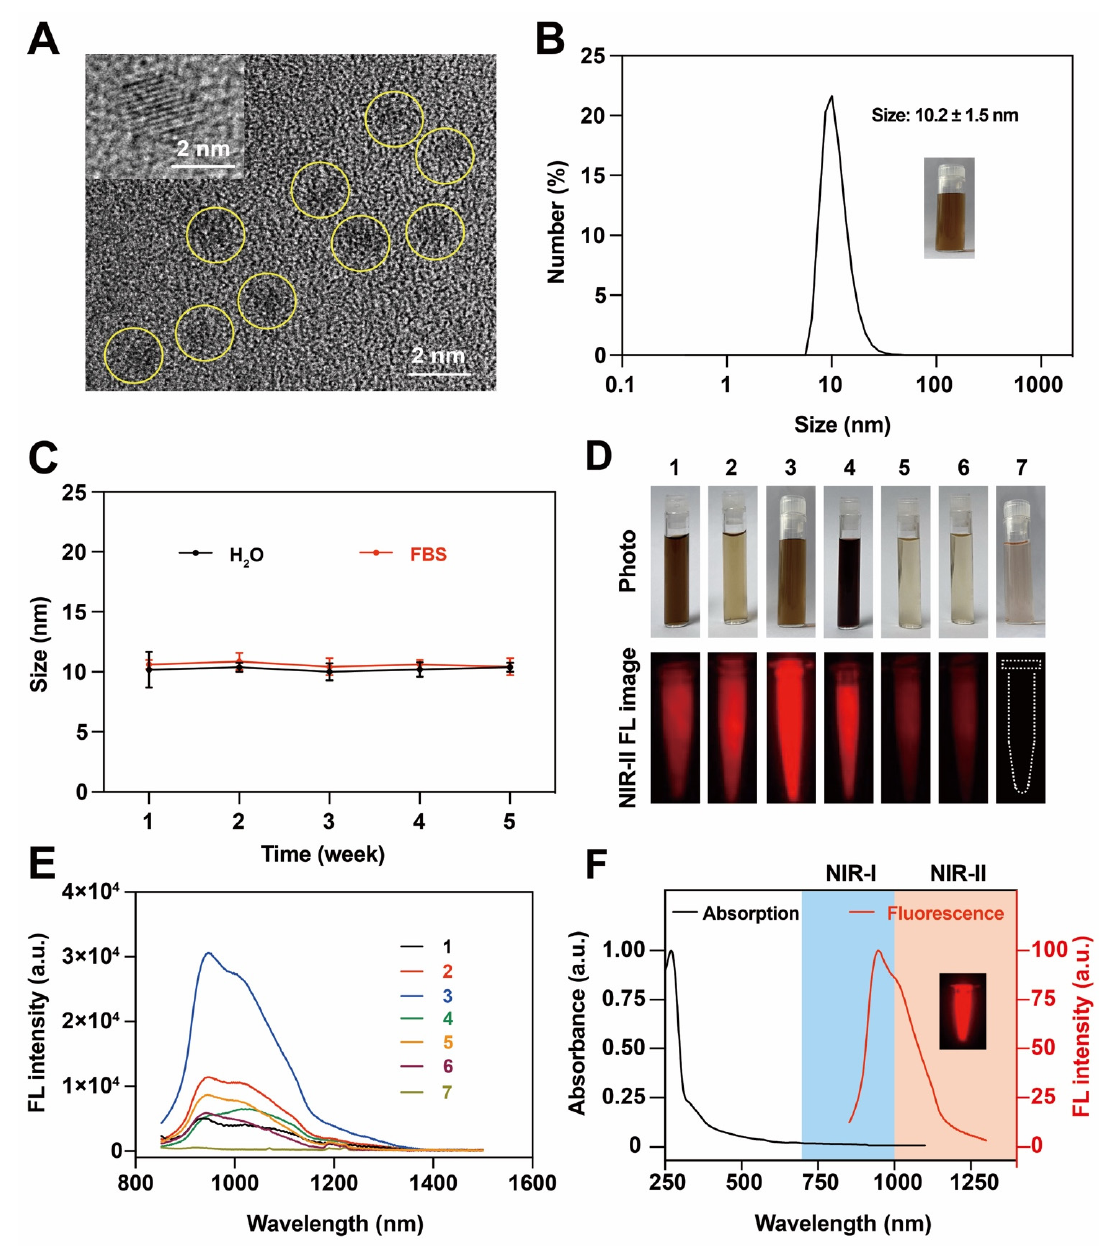
Figure 1. Characterization of BSA@Au. ( A ) The HRTEM image of BSA@Au. The inset was the lattice structure of BSA@Au. ( B ) Hydrodynamic size of BSA@Au. The inset was the digital